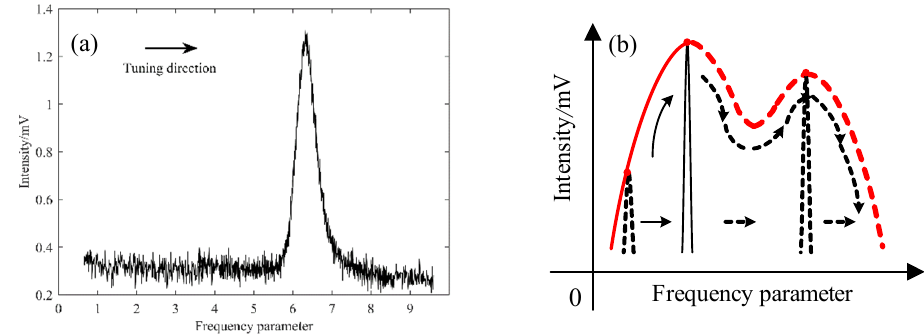
Figure 7. Profile of the intensity tuning curve obtained by the F-P cavity. ( a ) Frequency diagram of the longitudinal mode; ( b ) schematic of the profile detection of the intensity tuning curve.